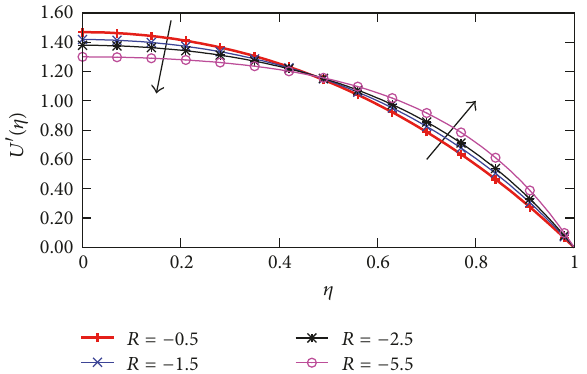
Figure 9: Effect of negative Reynolds number 𝑅 on the longitudinal